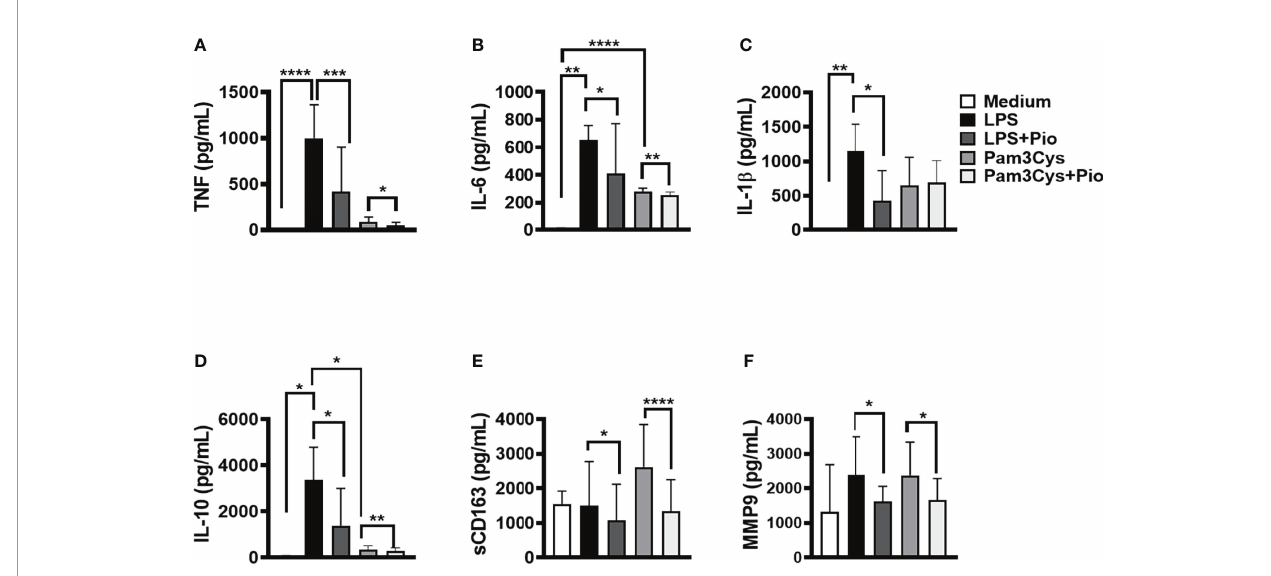
FIGURE 2 | Pioglitazone downregulates immune response induced by TLR2 and TLR4 activation. Peripheral blood mononuclear cells (PBMCs) of healthy subjects (HSs) (n = 10) were cultured in the presence and absence of lipopolysaccharide (LPS) (10 ng/ml), Pam3Cys (100 ng/ml), or pioglitazone (1 µM) for 24 h. The levels